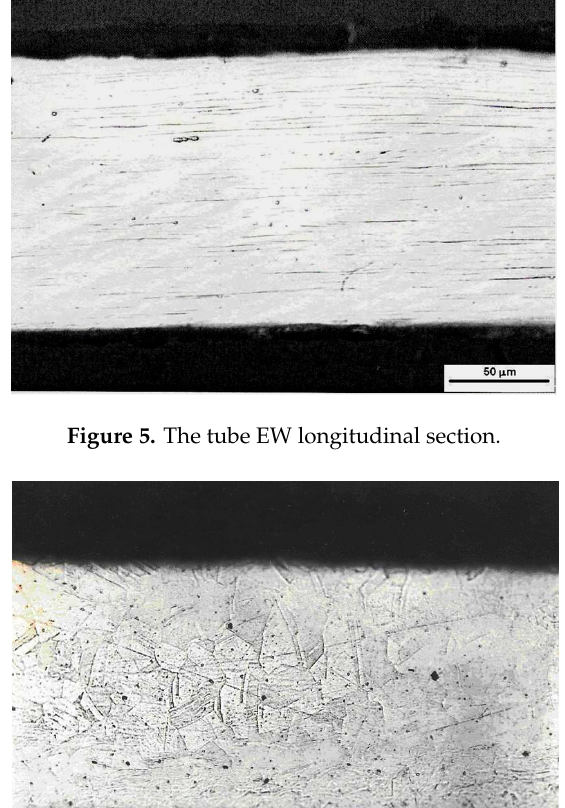
Figure 4. The stresses and strains during drawing without a mandrel.